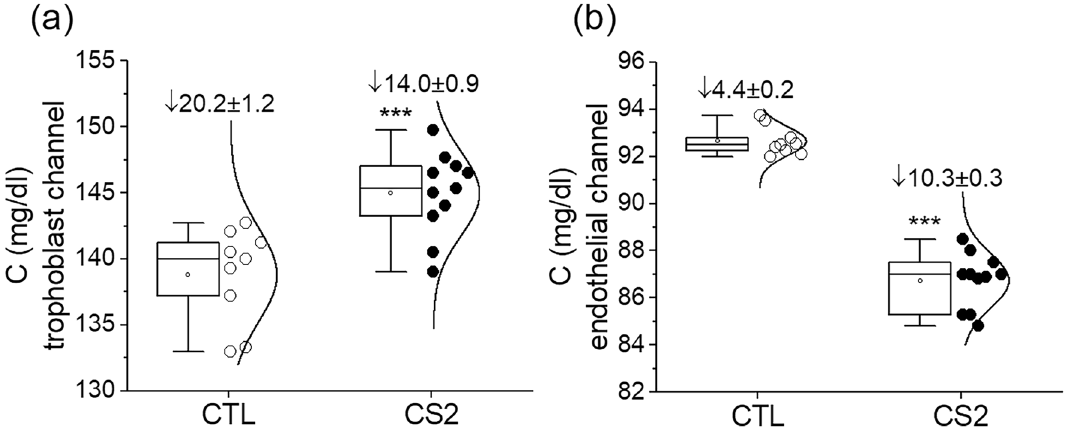
Figure 4. Glucose concentrations after 2 h perfusion experiments in ( a ) the trophoblast channel and ( b ) the endothelial channel. Reduction is shown relative to initial concentration at the beginning of the experiment. *** p < 0.001.